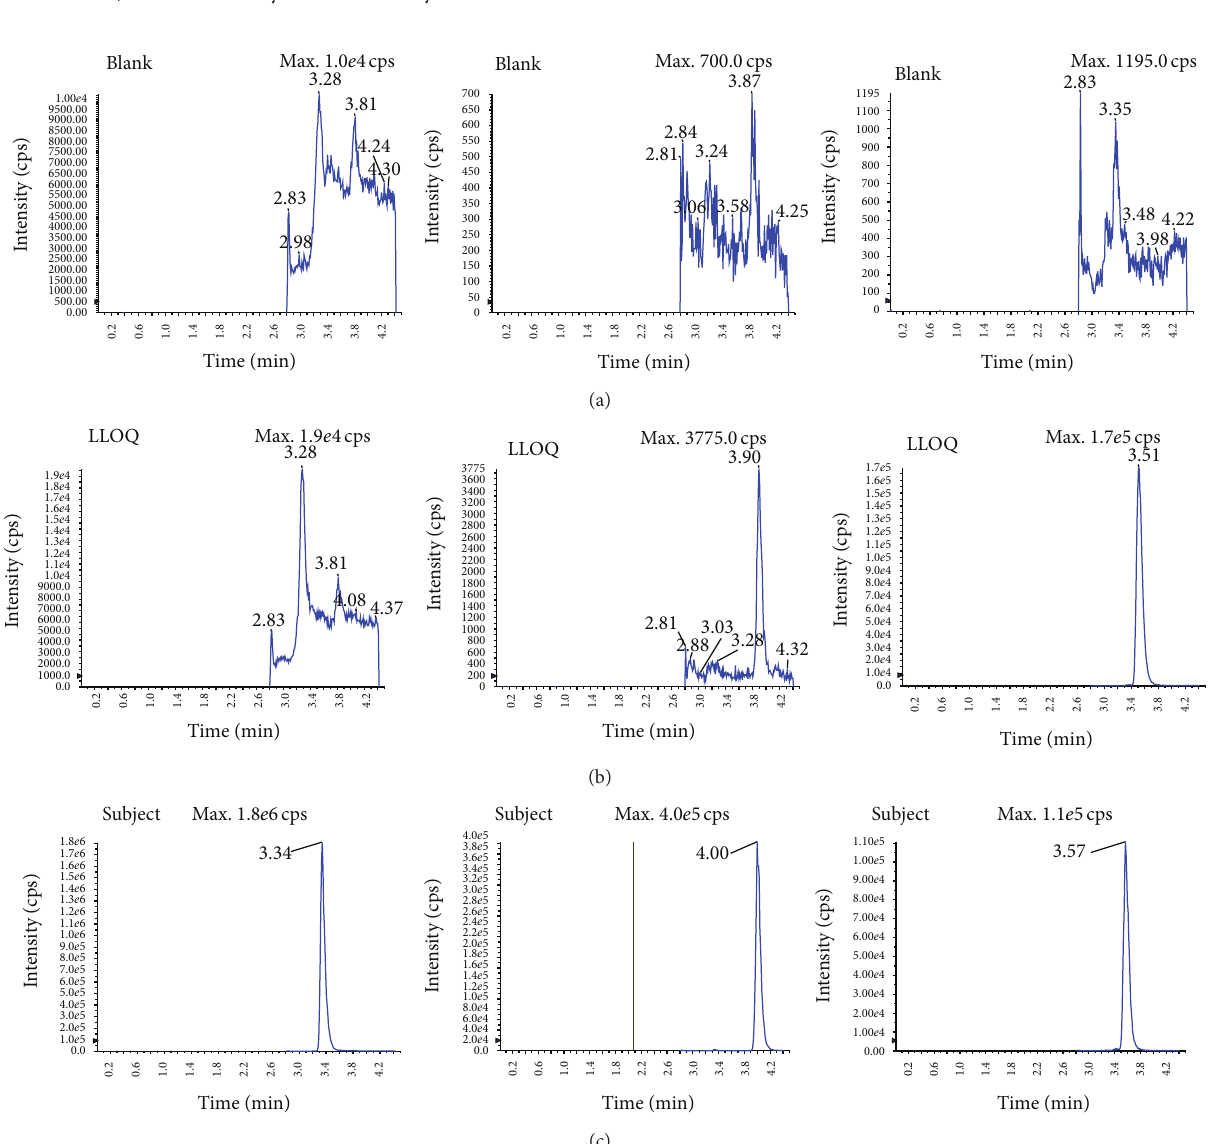
Figure 2: Representative MRM chromatograms for NA (I), NUA (II), and IS 5-FU (III) in human plasma: (a) blank plasma sample; (b) blank plasma sample spiked with NA and NUA at the lowest limit of quantification (5ng/mL) and IS (1000ng/mL); (c) plasma sample obtained from a subject 12h after oral administration of 3 tablets of Niacin